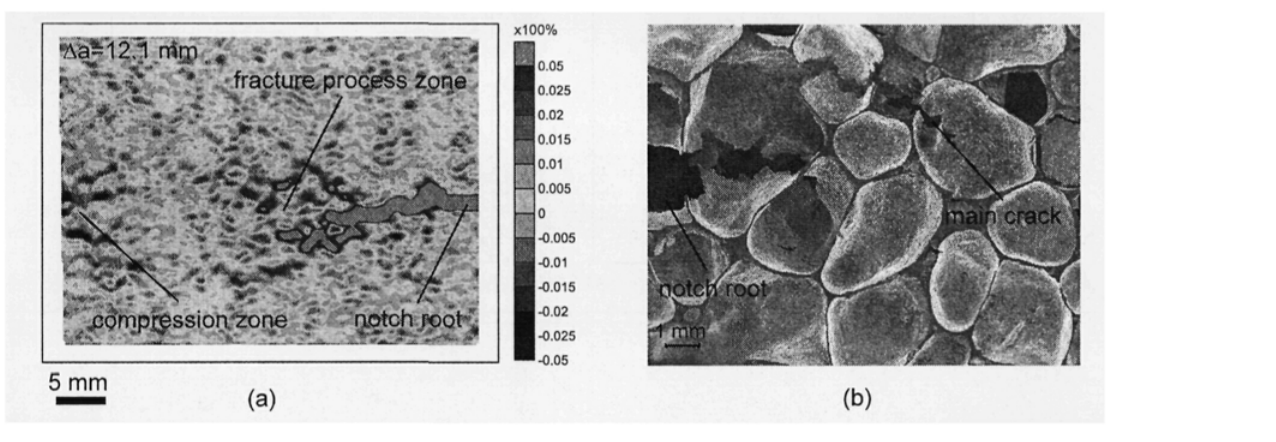
Fig. 4: Surface strain distribution on a CT-specimen (W=100 mm, p=0.25 g/cm3) in front of the notch root at a certain crack extension Aa (a), and micrograph .of the foam structure in front of the notch root showing the main crack, crack bridges and micro-cracking